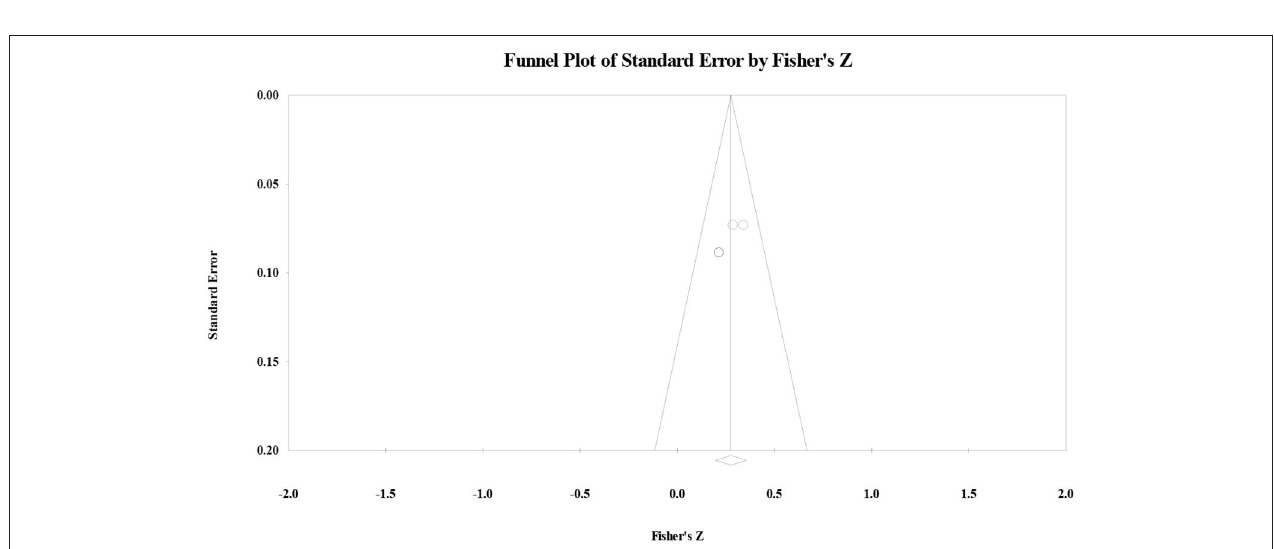
FIGURE 4 | Funnel plot of the correlation effect size between vocabulary knowledge and reading comprehension for undergraduate students.